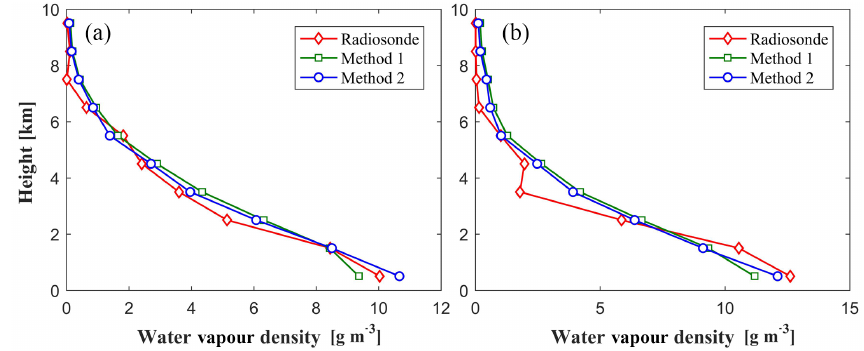
Figure 9. Water vapour profile comparison derived from different tomographic methods and radiosondes at specific epochs, 14 May 00:00UTC (a) and 19 May 12:00UTC (b) .